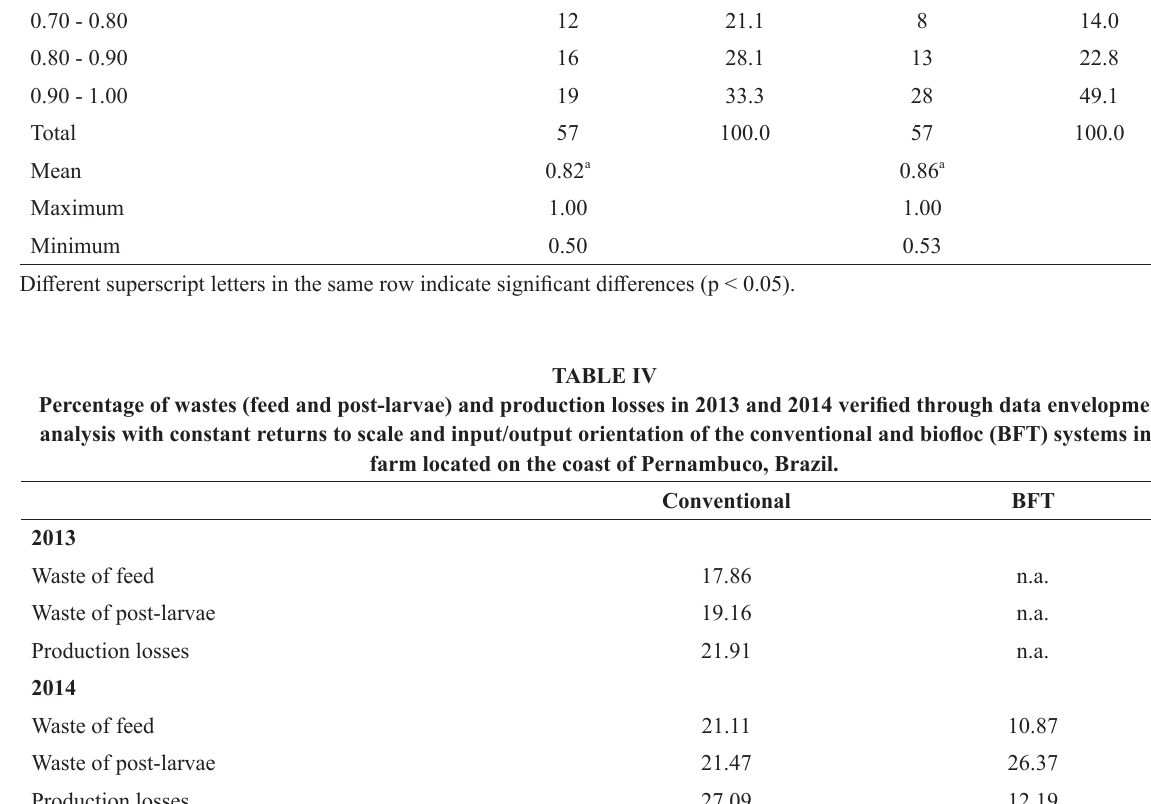
Distribution of production cycles performed in all ponds (conventional and biofloc systems) by technical efficiency classes, obtained through data envelopment analysis (DEA) with constant (CRS) and variable returns to scale (VRS) over the years 2013 and 2014 in a farm on the coast of Pernambuco, Brazil.